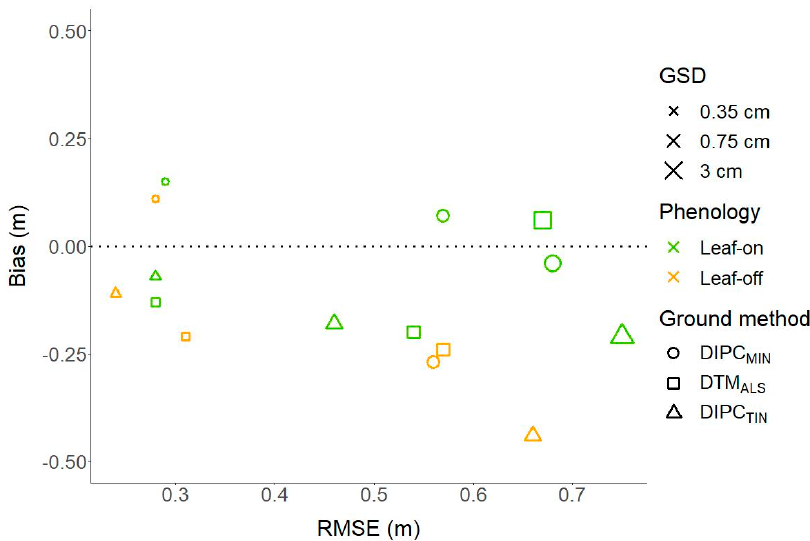
Figure 3. Seedling height estimation bias versus root mean square error (RMSE) for all ground sampling distance (GSD), phenology, and ground determination methods. DIPC MIN = ground elevation set to the minimum of the local DIPC; DTM ALS = ground elevation based on the light detection and ranging (LiDAR) digital terrain model; DIPC TIN = ground elevation based on a triangular irregular network derived from the DIPC.